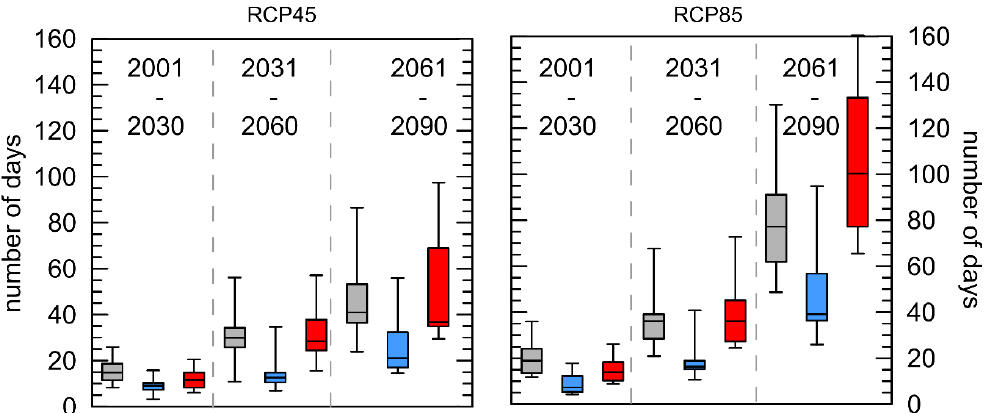
Figure 2. Boxplots of mean anomalies of the “Warm spell duration indicator” (WSDI) per year with reference to the 30-year period 1971–2000 for the three cities London (grey), Luxembourg (blue), and Rome (red) and two different RCPs. Whiskers = 5/95 percentile.